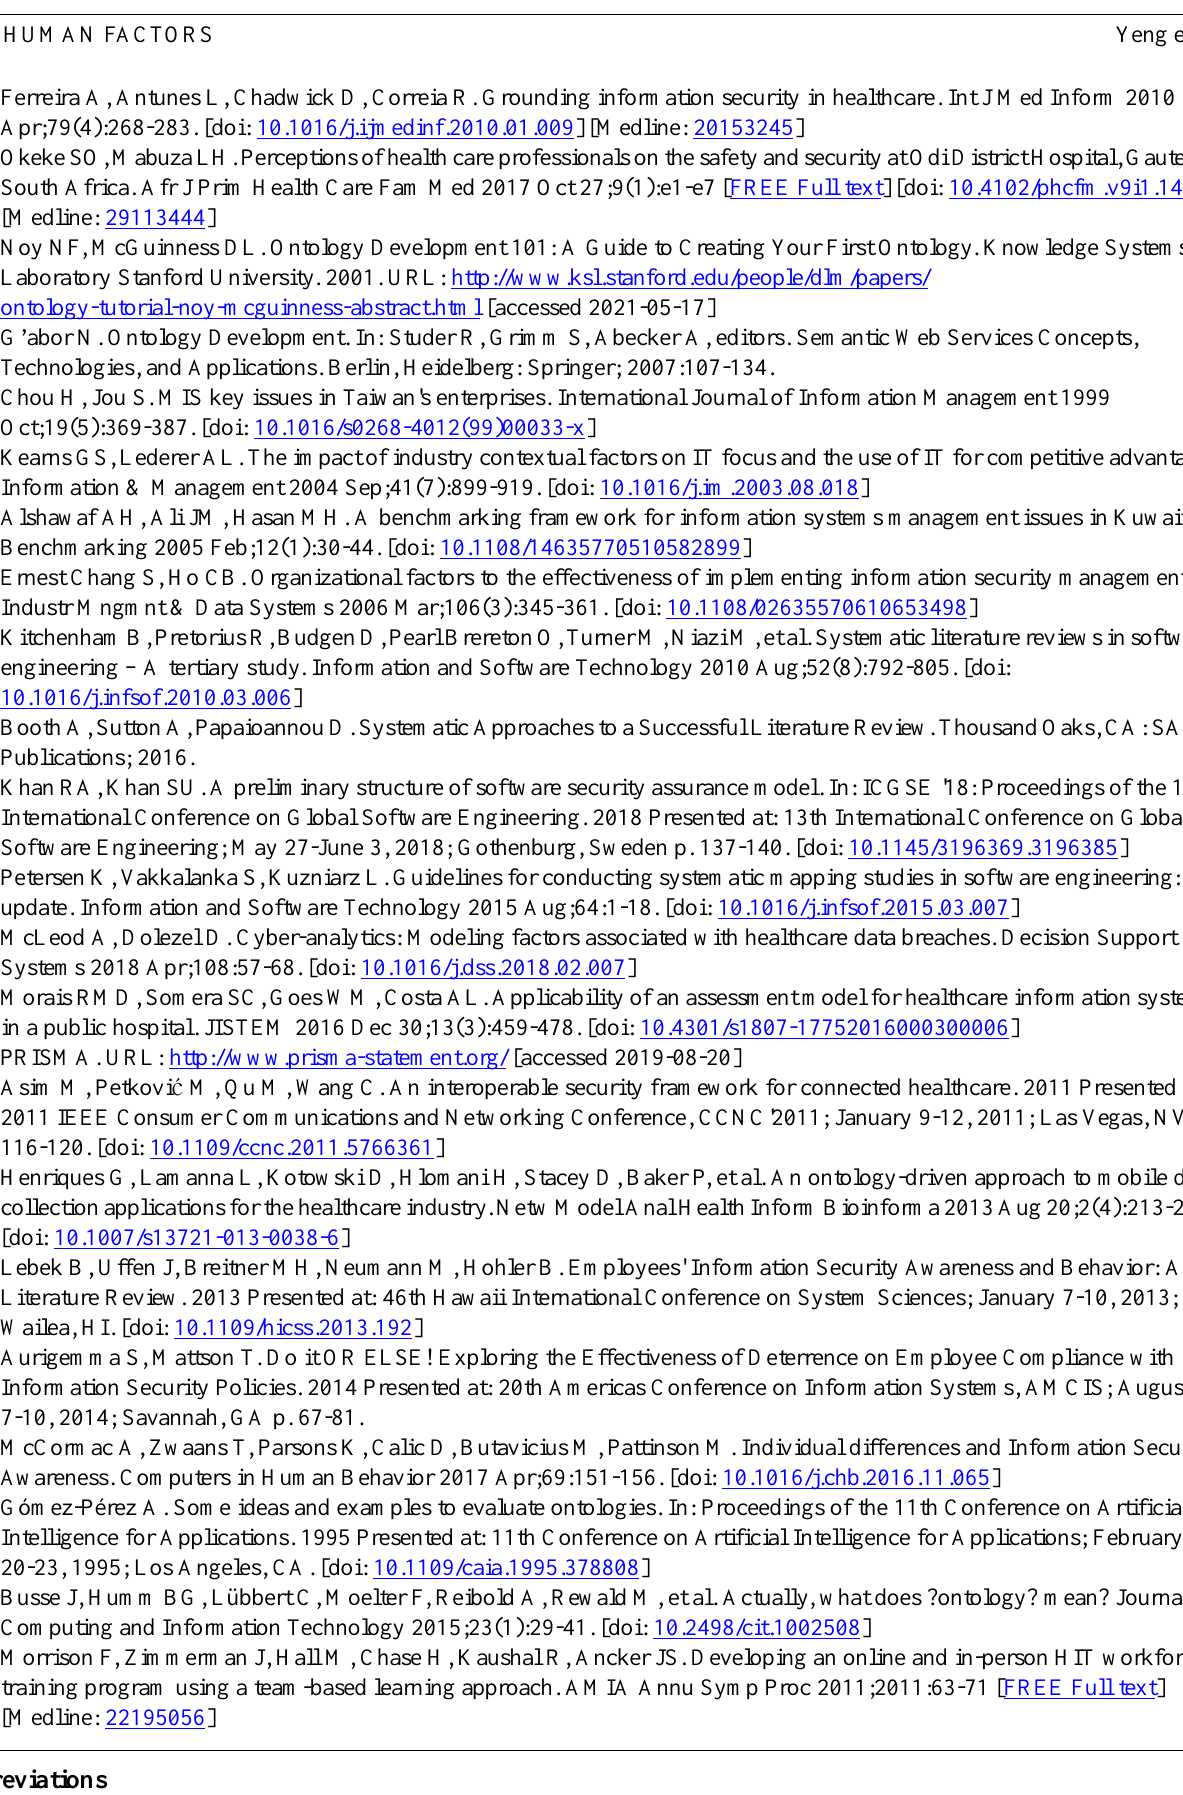
GDPR: General Data Protection